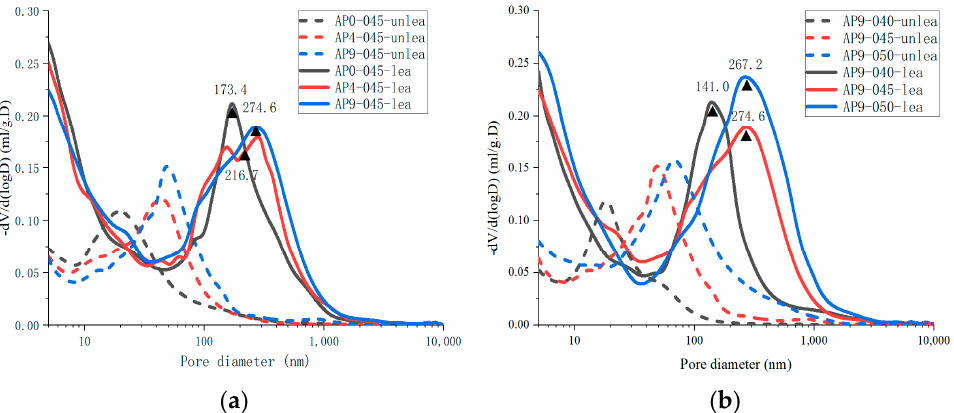
Figure 18. The porosity of the unleached and leached cement pastes: ( a ) different dosages of the AS accelerator; ( b ) different w/c.